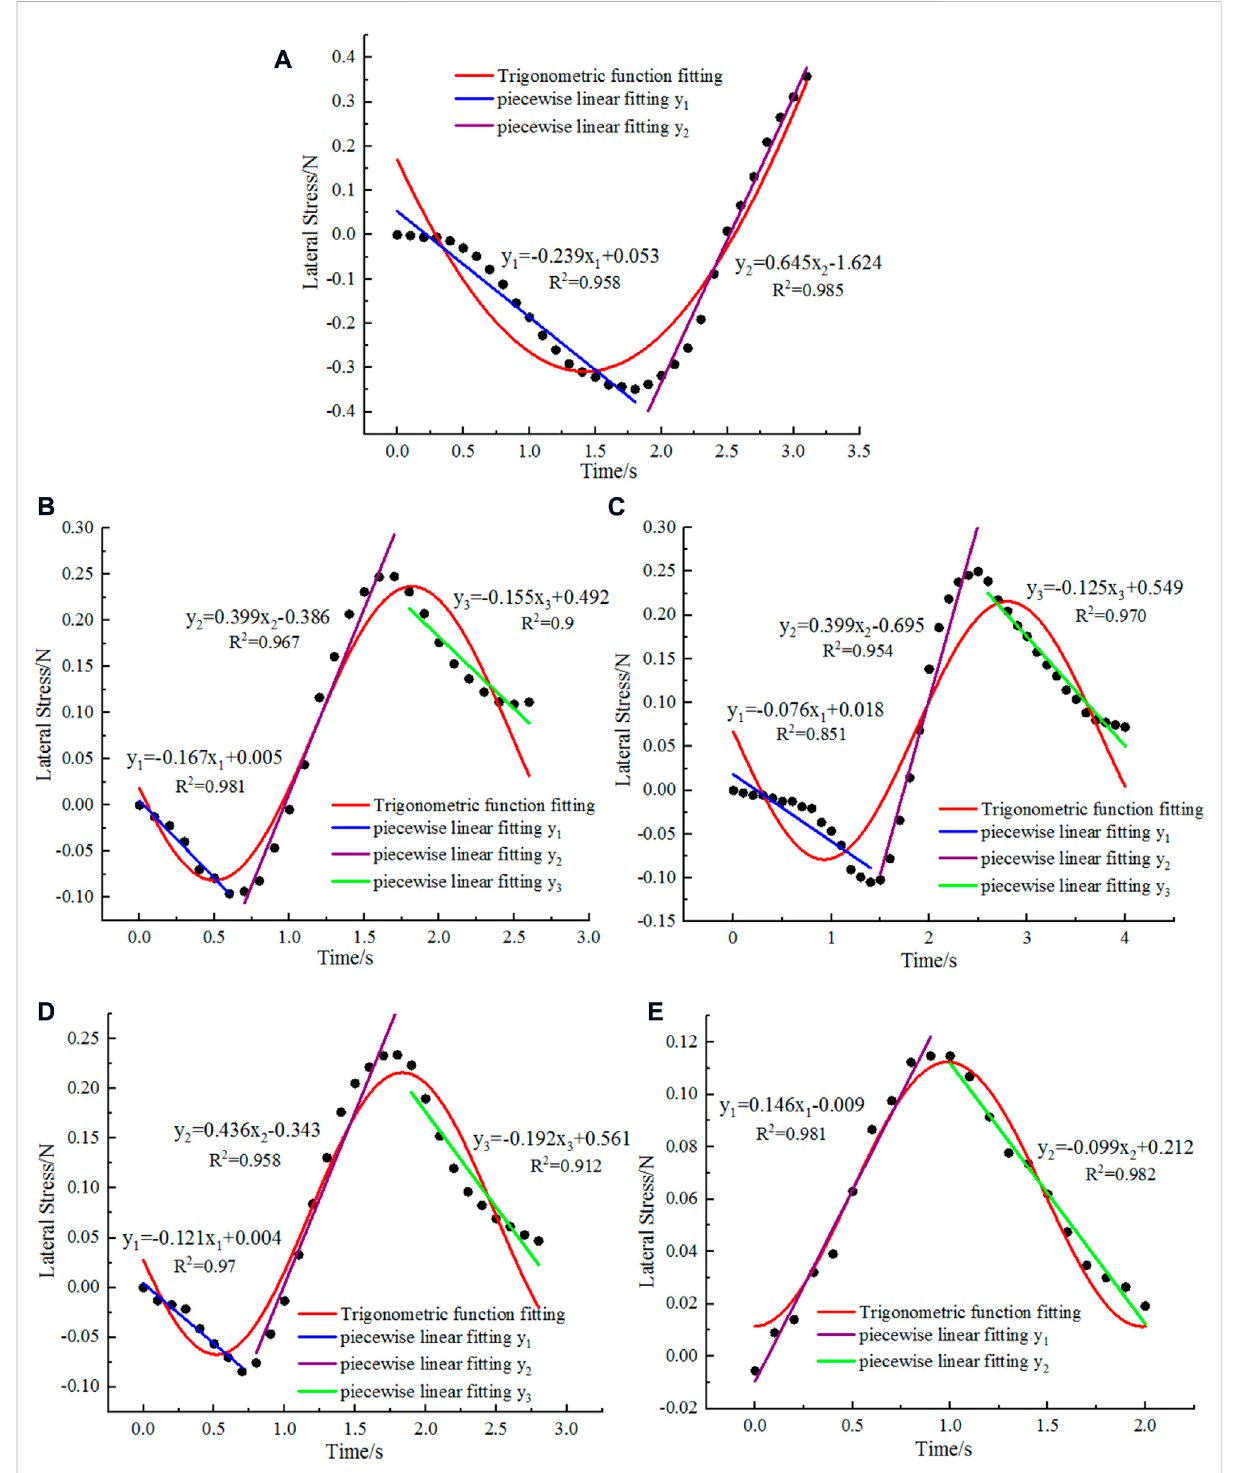
FIGURE 8 Temporal variation inlateral stress atthe different lateral positionsin thedeep soil layer: (A) 20 mm; (B) 40 mm; (C) 60 mm; (D) 80 mm; and (E) 100